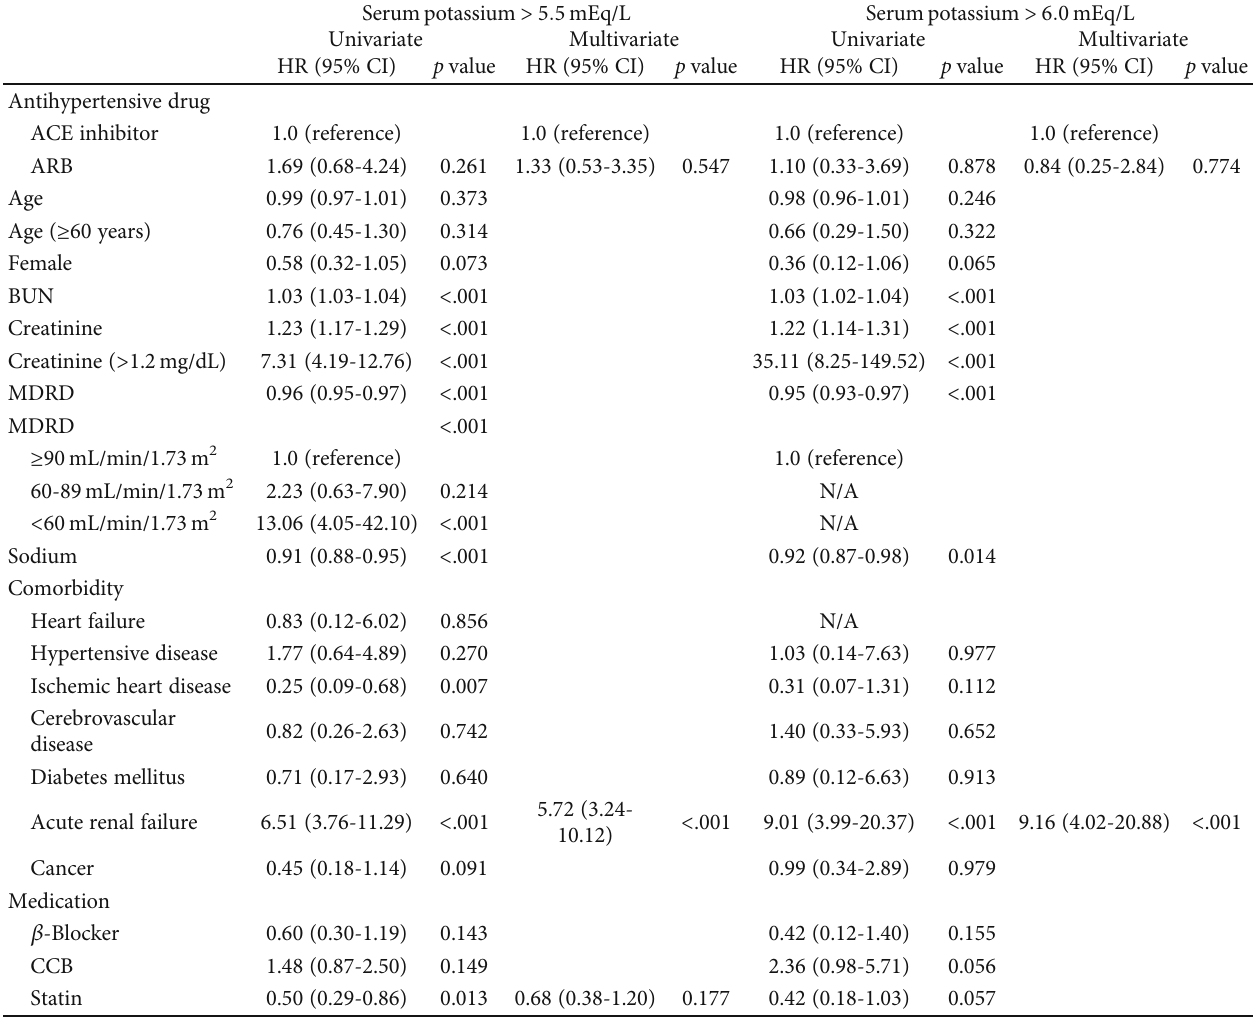
Table 2: Causal relationship between hyperkalemia and antihypertensive drug use. Serumpotassium > 5 :